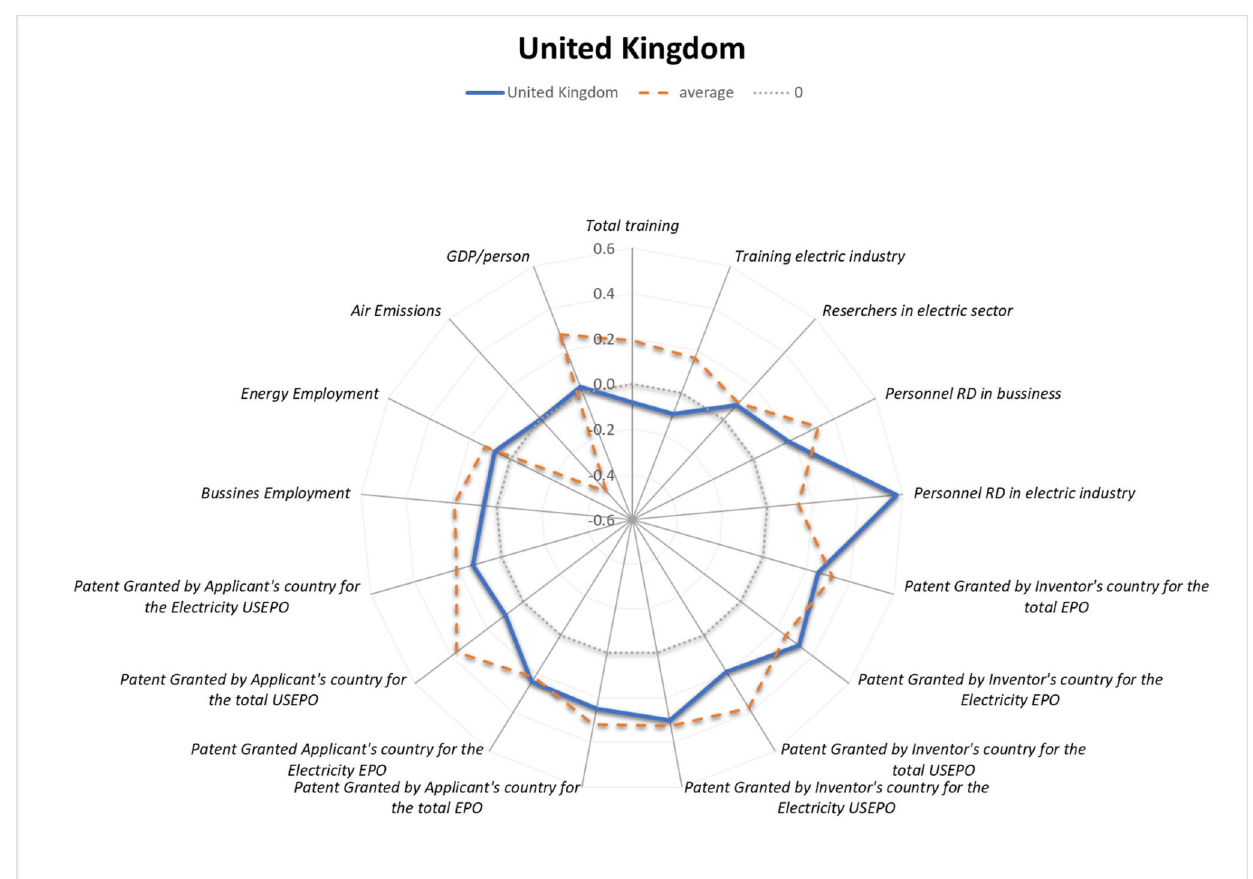
Figure 36. Synergy and trade-off occurrence—UK. Source: Authors’